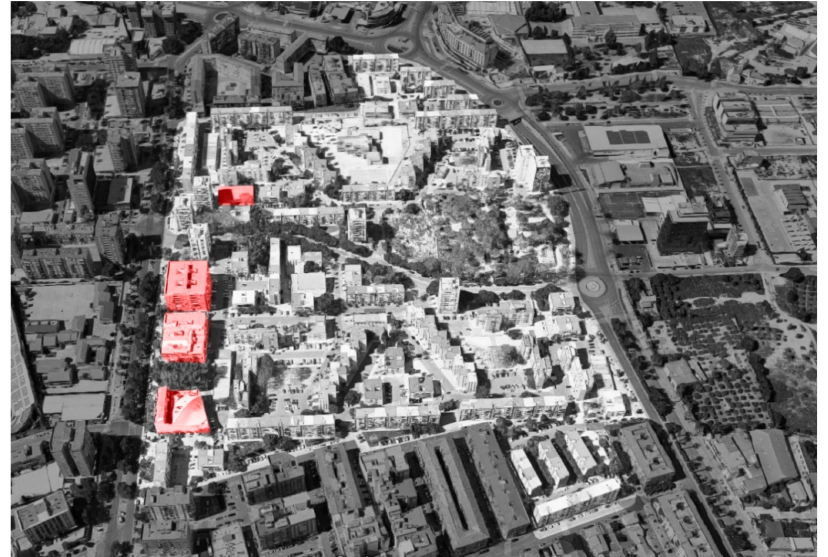
Figure 3. Aerial view of La Paz neighborhood (1961). Authors’ image based on Google Maps 3D